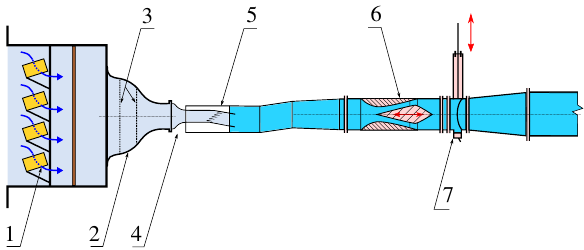
Fig. 2 . Schematic depiction of the modular wind tunnel with the mounted flutter test facility. round-rectangular transition (4), flutter test facility with tested blade cascade (5), outlet part equipped with con- trol nozzle (6) and fast acting gate valve (7) connected to a vacuum tank. The flow in the cascade is controlled us- ing adjustable tailbords, throttling tailboard and regulat- ing nozzle. The tested blades can be independently os- cillated and a resulting flow field and mutual interaction between blades can be measured using numerous tech- niques including fast-response miniature pressure trans- ducers, pressure sensitive paints, fibre optics interferom- etry, thermo-anemometer probes and high-speed torque- meter.Due to only slightly supersonic inlet velocity and limited space at the test section upper wall, it was decided that the inlet channel would be straight with no divergence. Preliminary tests would be run and according to the results of the first tests, a suction through the upper wall will be added to suppress reflection of shock waves back to the Fig. 1. Test section with uncovered side wall and visible blade